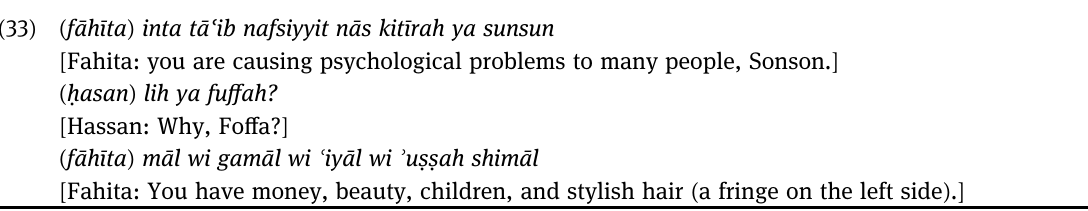
Fahita stresses Hassan ’ s physical appeal ( 33 ) , by enumerating his charms and referring to the presence of some people who are jealous of him.